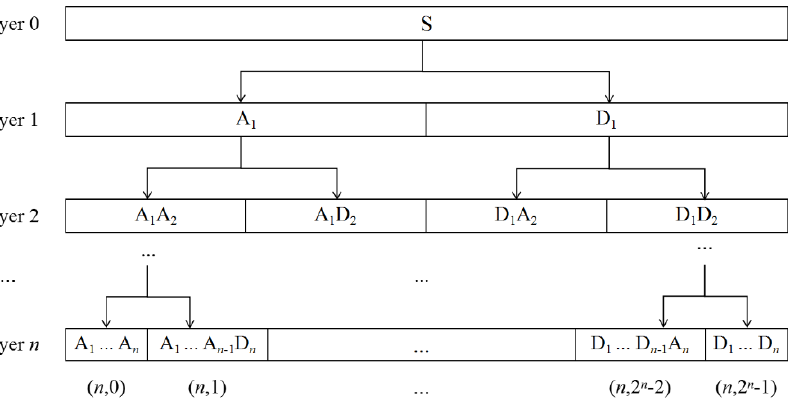
Figure 1. Diagram of wavelet packet decomposition. S: raw signal; A: low-frequency signal; D: high-frequency signal.